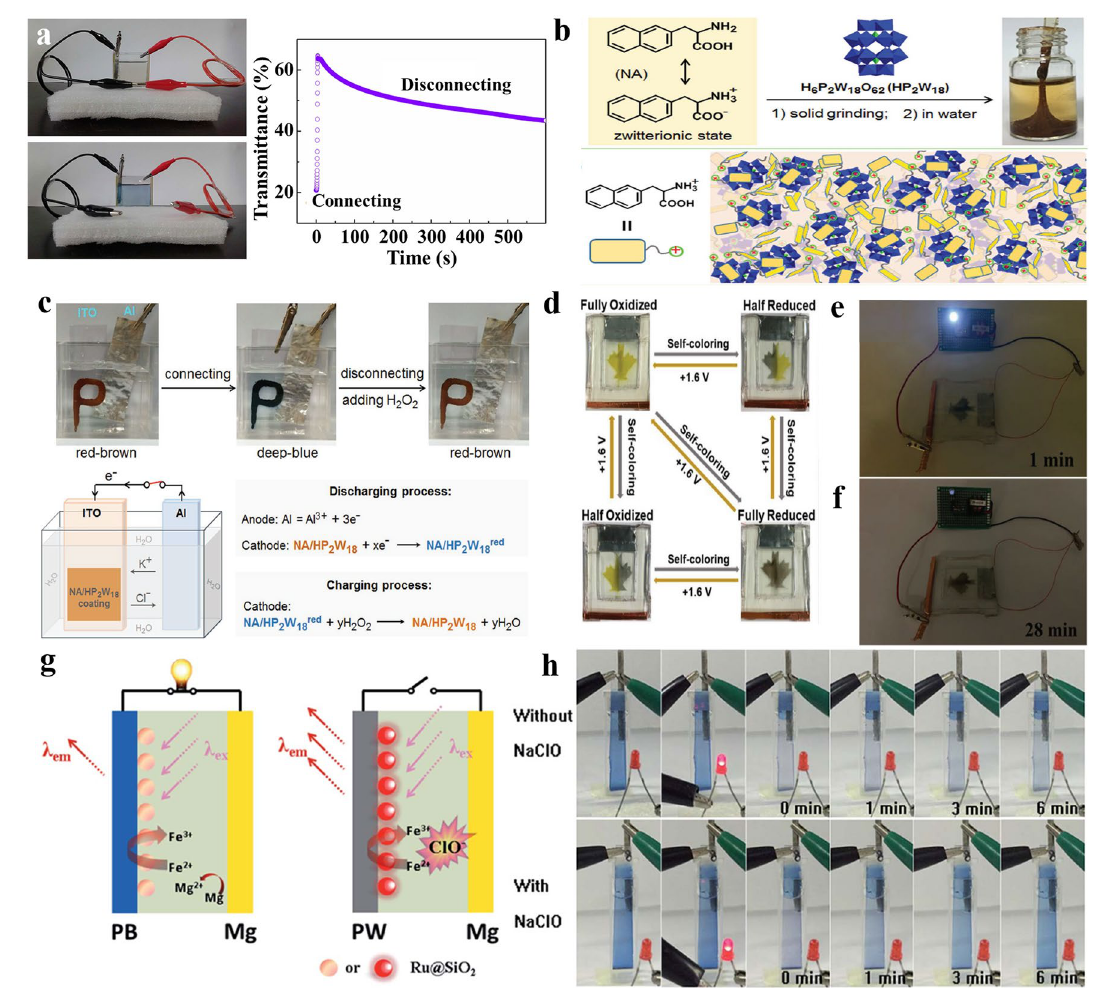
Fig. 11 Advances in self-powered MERABs. a Demonstration of the color restoration process without external input power, and the corre- sponding in-situ transmittance spectra of self-powered MERABs with connecting and disconnecting situation. Reproduced with permission [23]. Copyright 2014, Springer Nature. b Chemical structures of NA and HP 2 W 18 and the corresponding schematic packing model of the NA/HP 2 W 18 adhesive. c Demonstration of the NA@HP 2 W 18 @Al device with reversible color switching, and the corresponding schematic illustration of the working mechanism. Reproduced with permission [32]. Copyright 2018, Wiley–VCH. d Digital photographs of the self-powered display with color-tuning ability. e–f Digital photographs of 0.5 V LED powered by self-powered display. Reproduced with permission [125]. Copyright 2019, Wiley–VCH. g Scheme of self-powered Mg/PB MERABs. h Digital photographs of self-powered MERABs with/without NaClO 4 . Repro- duced with permission [126]. Copyright 2016, Royal Society of Chemistry. (Color figure